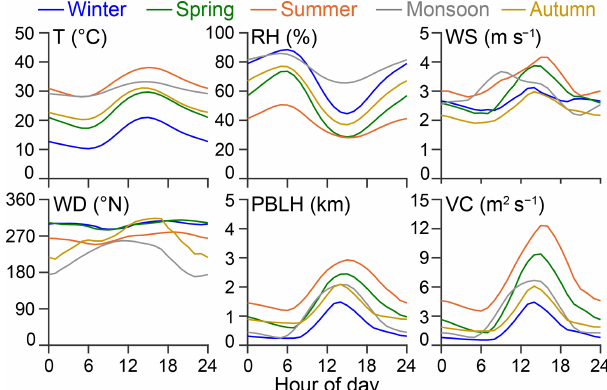
Figure 1. Diurnal profiles of meteorological parameters (temper- ature, relative humidity, wind speed, wind direction, planetary boundary layer height (PBLH), and ventilation coefficient) by sea- son. Average values by season and hour of day are presented for all parameters except wind direction. The median value is presented for wind direction. Ventilation coefficient (VC) = PBLH × wind